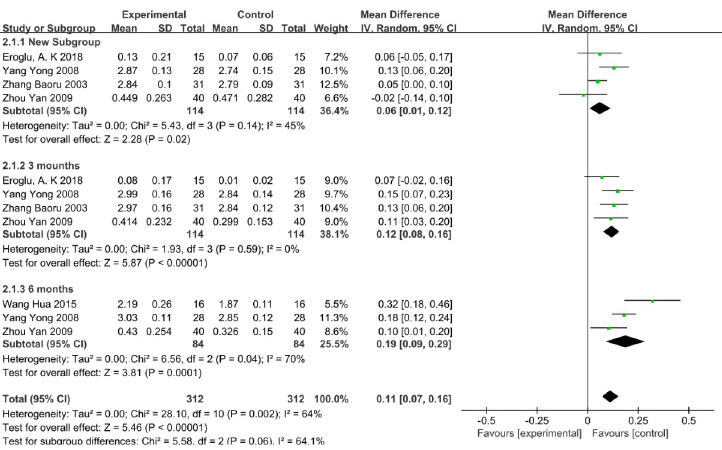
Fig 6. The status of PLI index at 1, 3, and 6 months between the VFR group and the Hawley group.